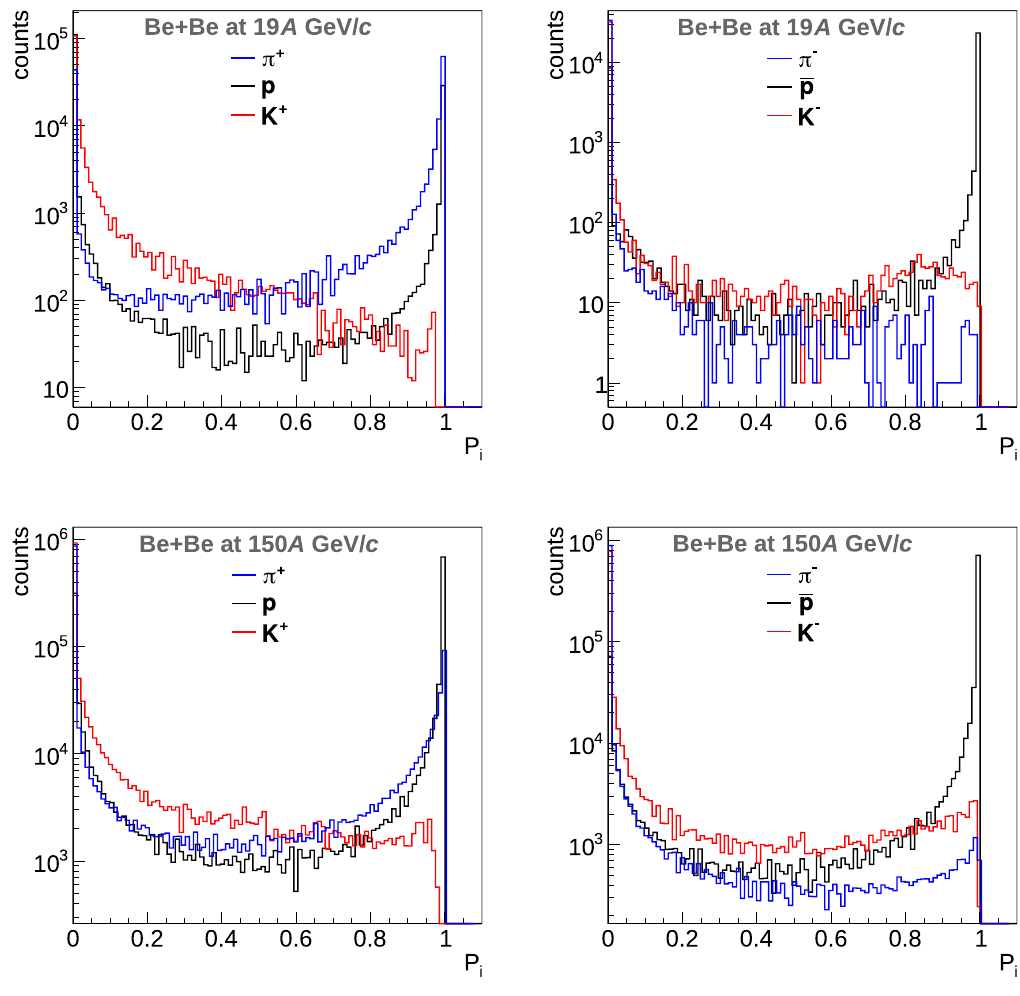
Fig. 13 Probability of a track being a pion, kaon, proton for positively (left) and negatively (right) charged particles from d E / d x measurements in PSD selected Be+Be collisions at 19 A and 150 A GeV /